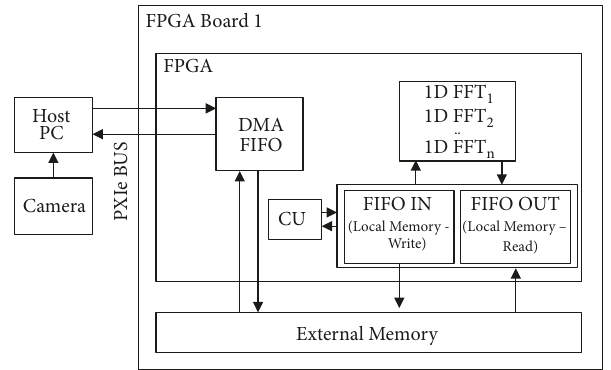
Figure 9: Block diagram of 2D FFT showing data transfer between external memory and local memory scheduled via a Control Unit